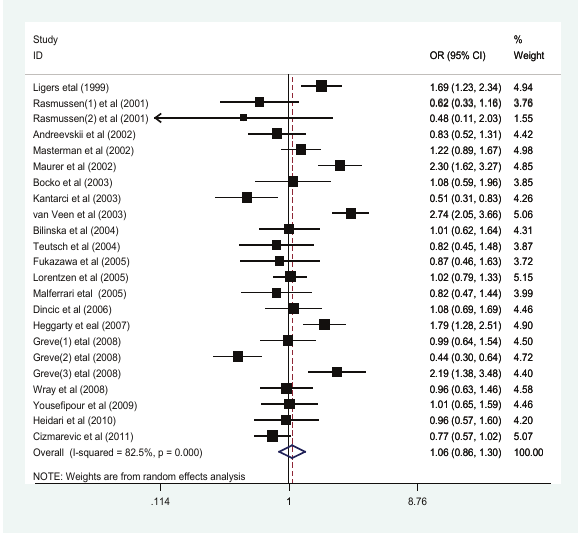
Figure 1: The forest plot of OR for CTLA-4 gene rs221775 A>G single nucleotide polymorphism and multiple sclerosis susceptibility under dominant model (GG+AG vs AA).